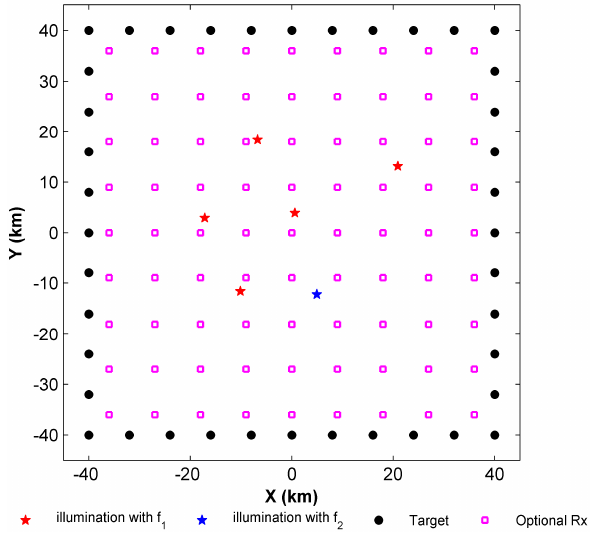
Figure 2. Simulation scenario.